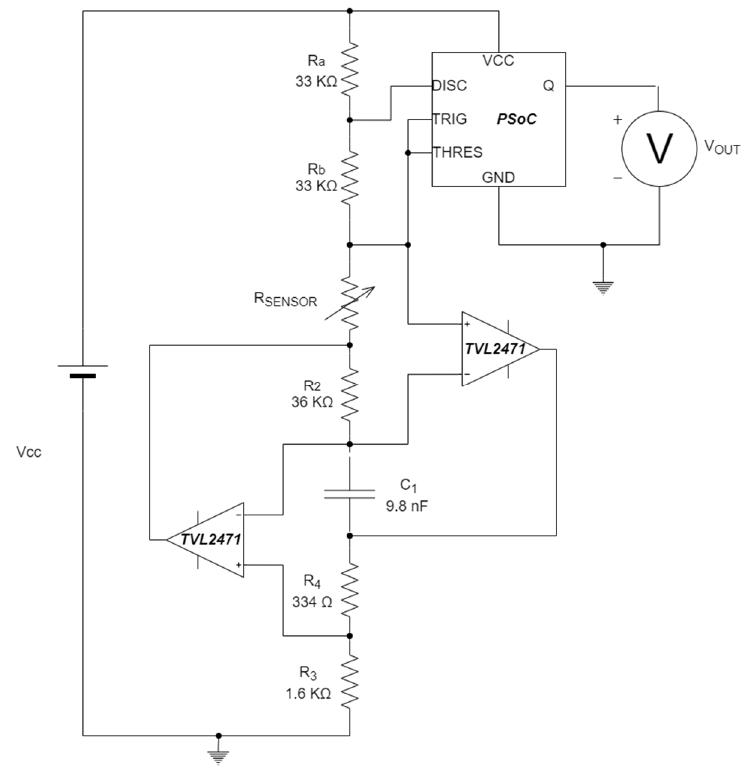
Figure 5. Design of the paper in which is based the design of the converter resistance-to-frequency [21].